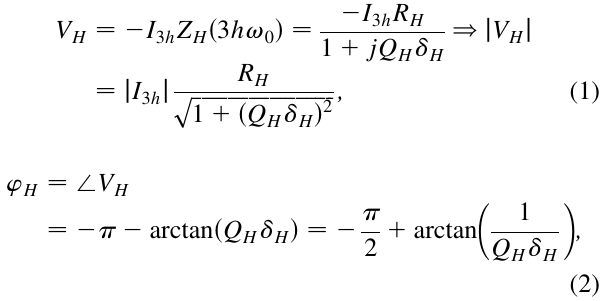
Main rf voltage